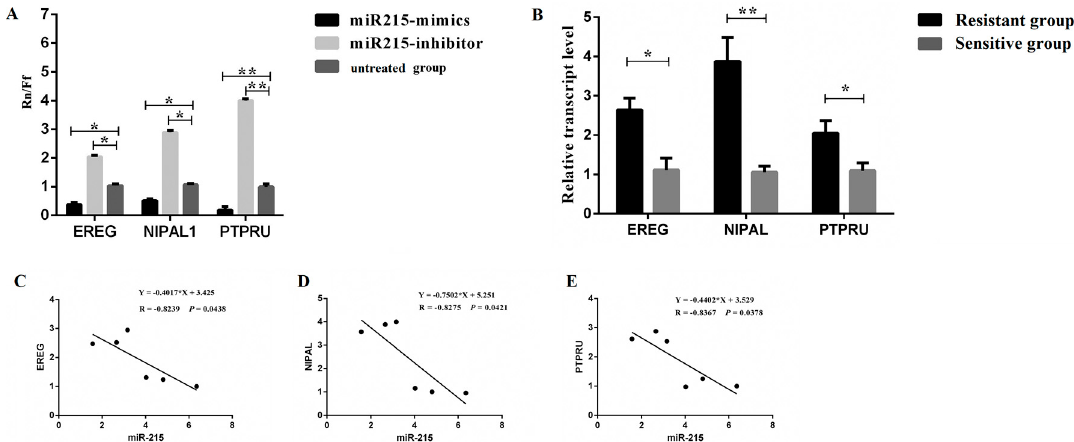
Figure 4. Verification of the targeting relationship between miR-215 and its target genes. ( A ) Detection of dual luciferase activity of target genes. ( B ) Expression of target genes in the duodenum between E. coli F18-resistant and sensitive Sutai weaned piglets. ( C – E ) Expression correlation analysis of miR-215 and target genes in which the expression data of miR-215 was derived from our previous study results [21]. *, p < 0.05; **, p < 0.01.